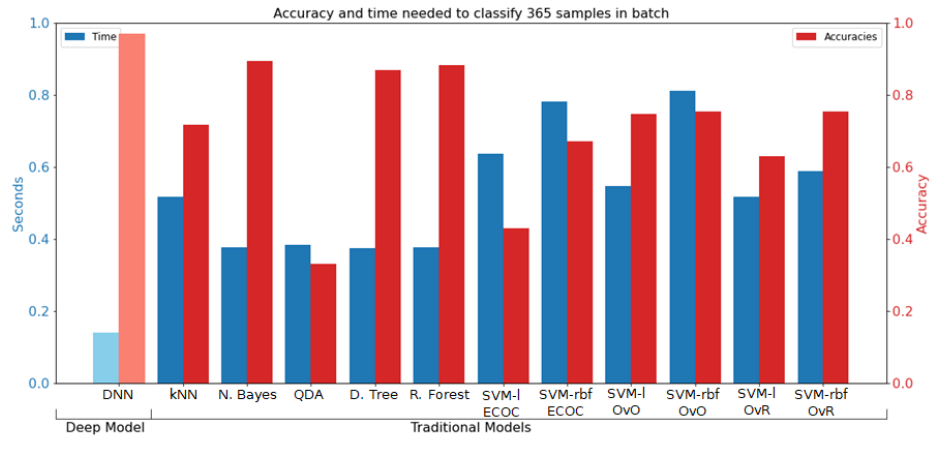
Figure 18. Prediction accuracy and evaluation time for traditional models in comparison to a deep learning-based model (DNN). The blue bars (left vertical axis) represent evaluation time and the red bars (right vertical axis) the prediction accuracy. The names of the models can be found in the main